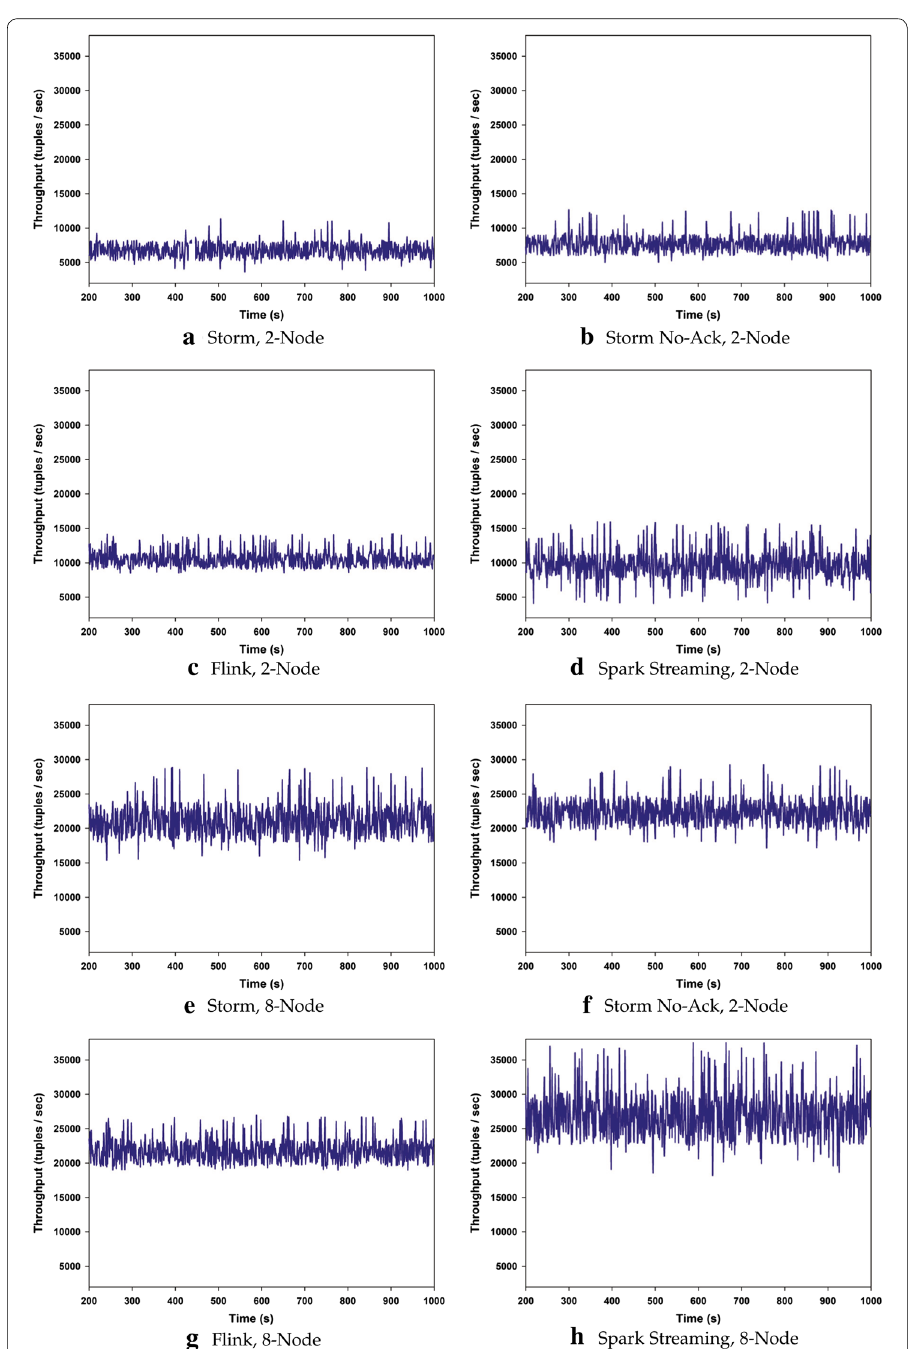
Fig. 14 Throughput of intended frameworks with different number of worker nodes for Model Training